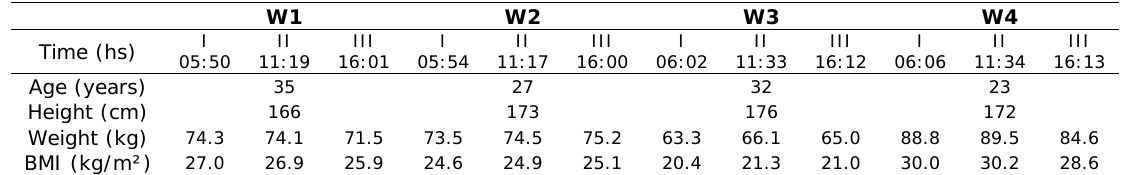
Table 2. Individual characteristics of evaluated workers